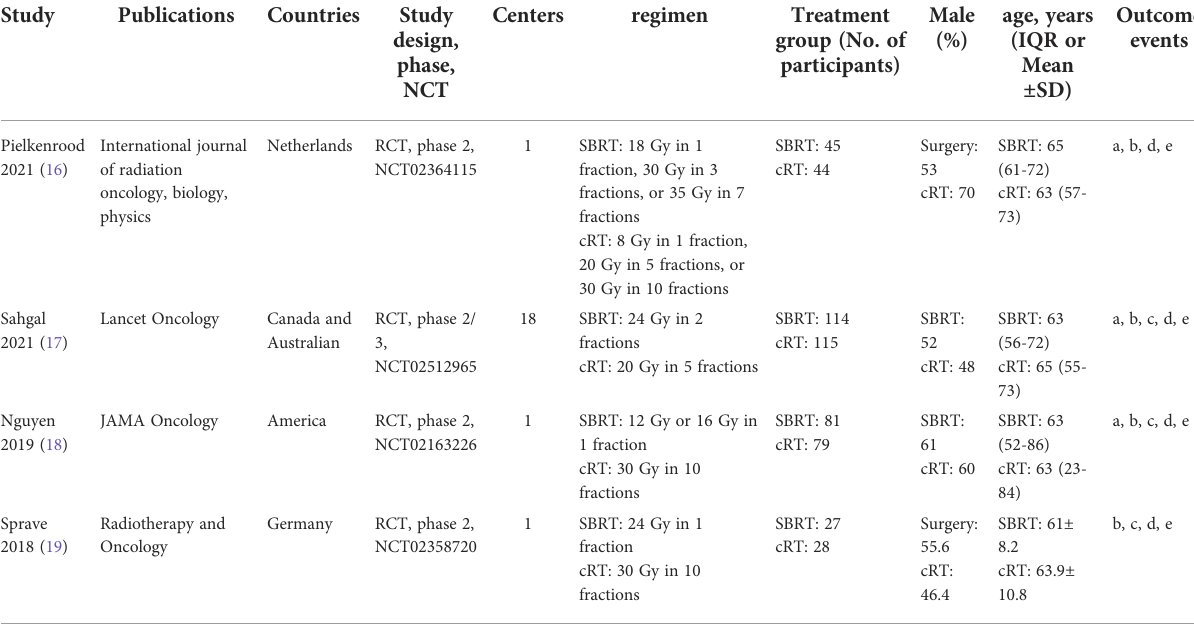
TABLE 1 Characteristics of the included studies and outcome events.